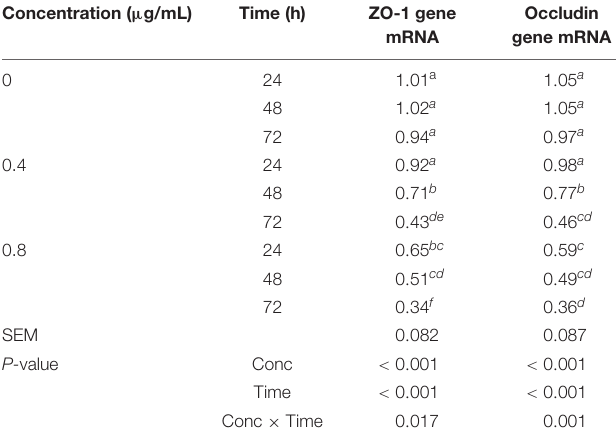
TABLE 7 | Effects of α -chaconine on the mRNA expression of tight junction protein ZO-1 and occludin genes in mouse intestinal epithelial